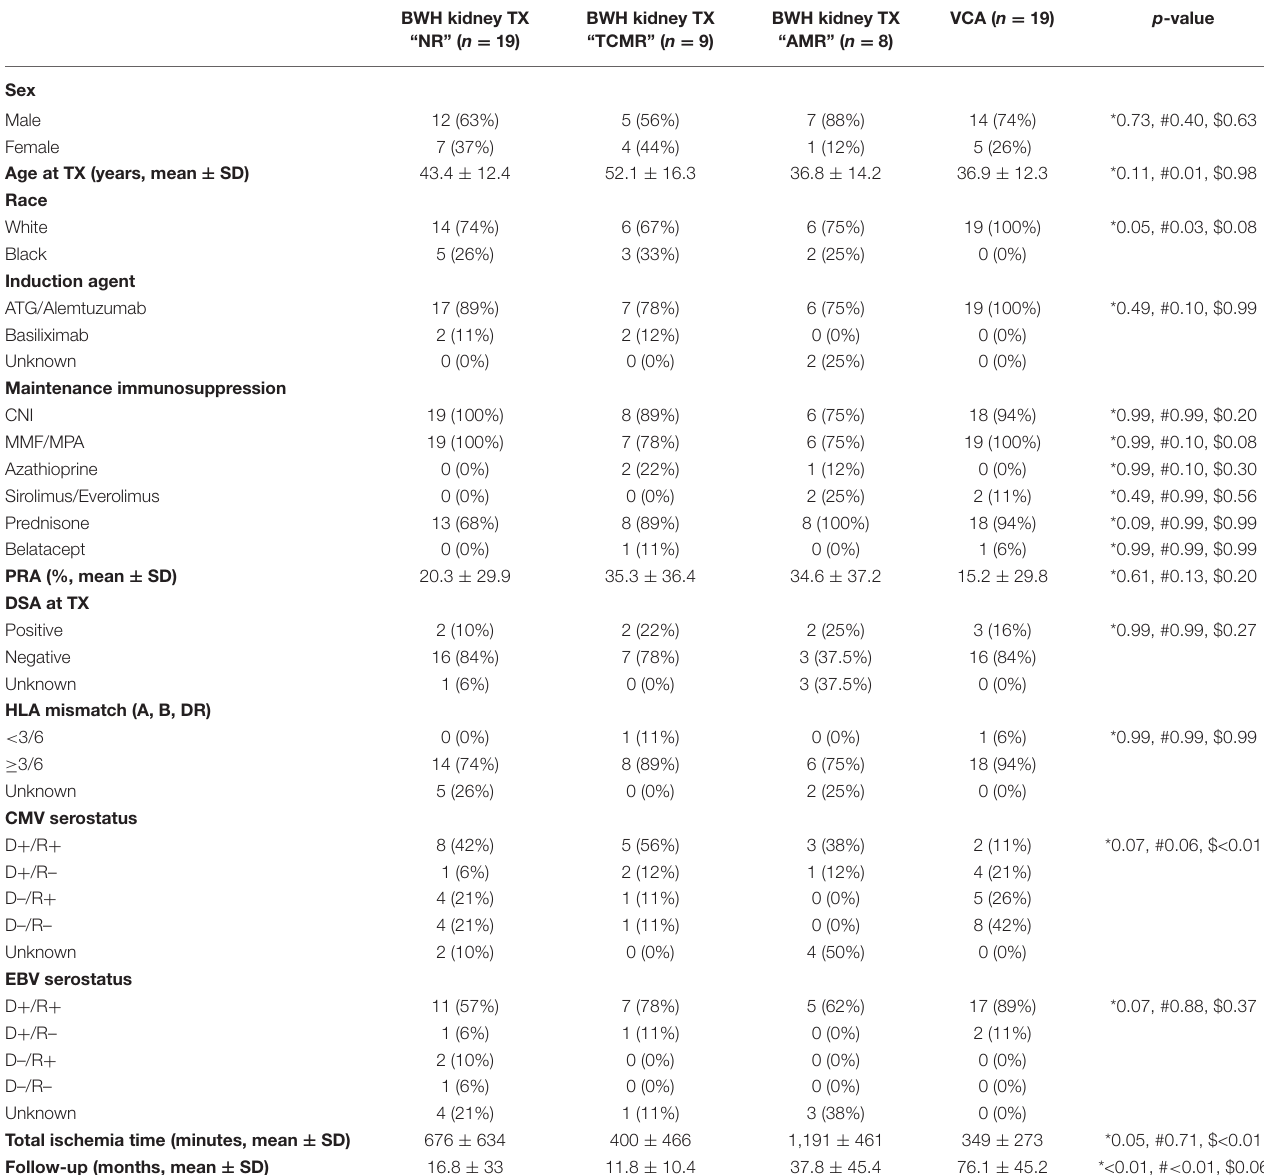
TABLE 3 | Kidney transplant recipients’